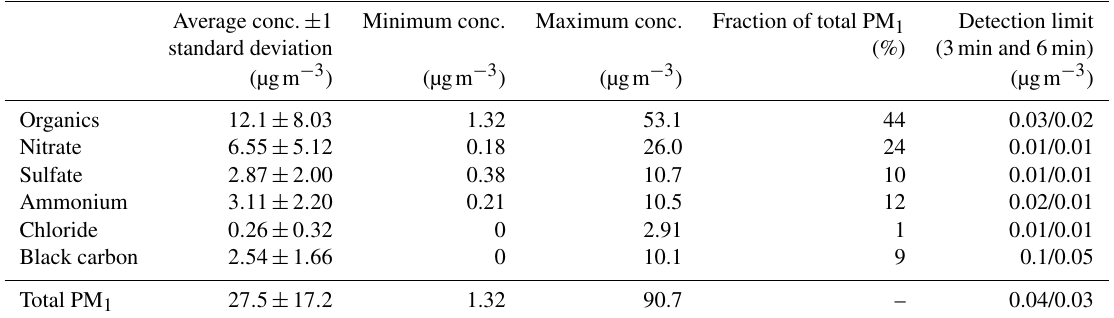
Table 1. Average ( ± 1 standard deviation), minimum, and maximum concentrations of the PM 1 species and the total PM 1 mass over the whole campaign, and the average contribution of each of the PM 1 species to the total PM 1